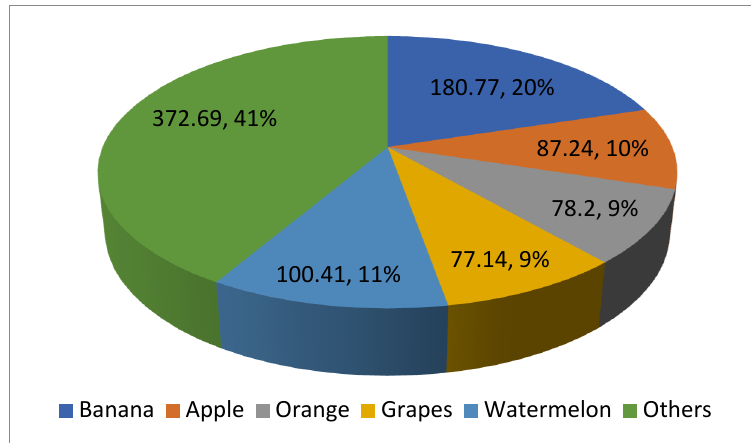
Figure 1. Worldwide production of major fruit crops.